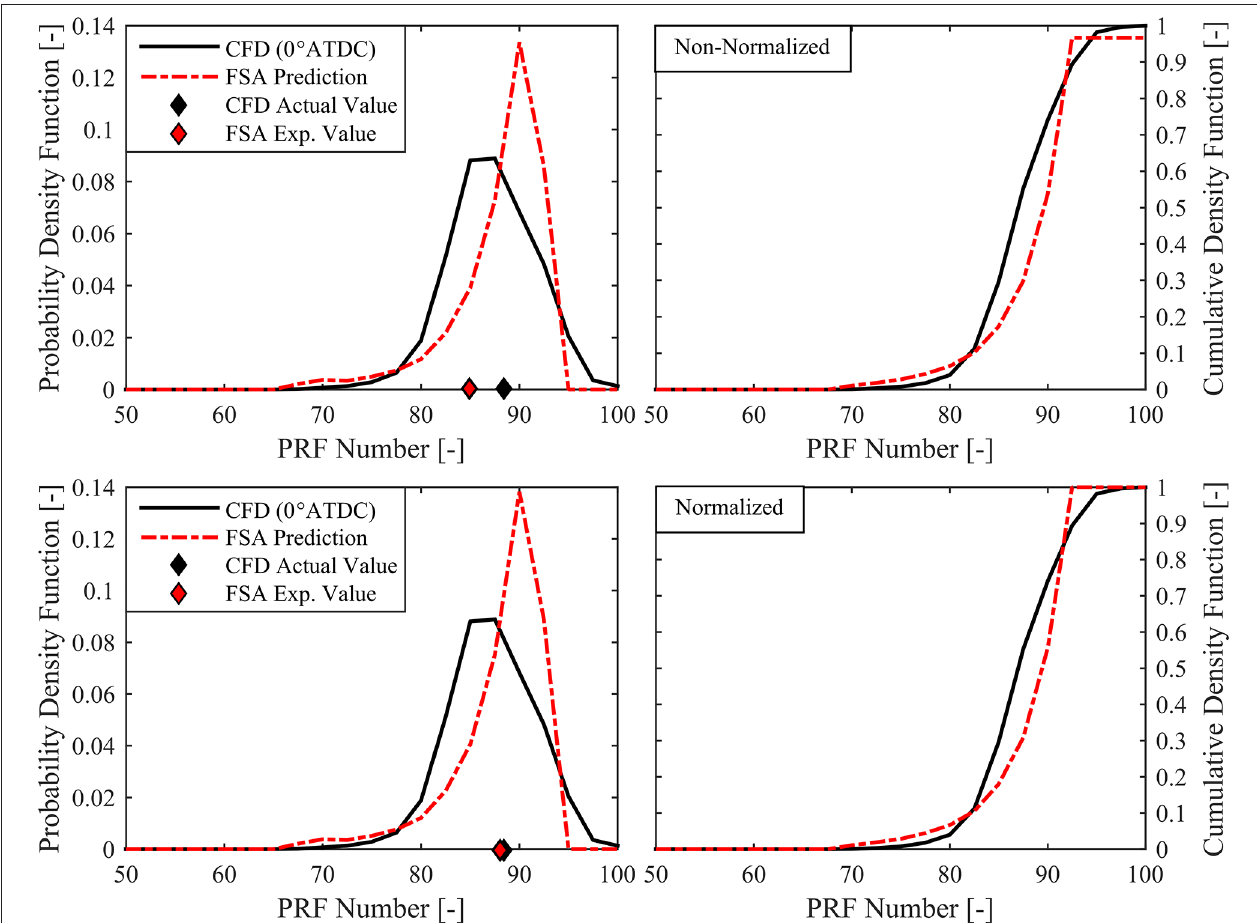
FIGURE 8 | PDF (Left) and CDF (Right) vs. PRF Number for non-reacting CFD at 0 ◦ CA for − 140 ◦ SOI case, compared to non-normalized FSA method result (Top) , and normalized FSA method result (Bottom)